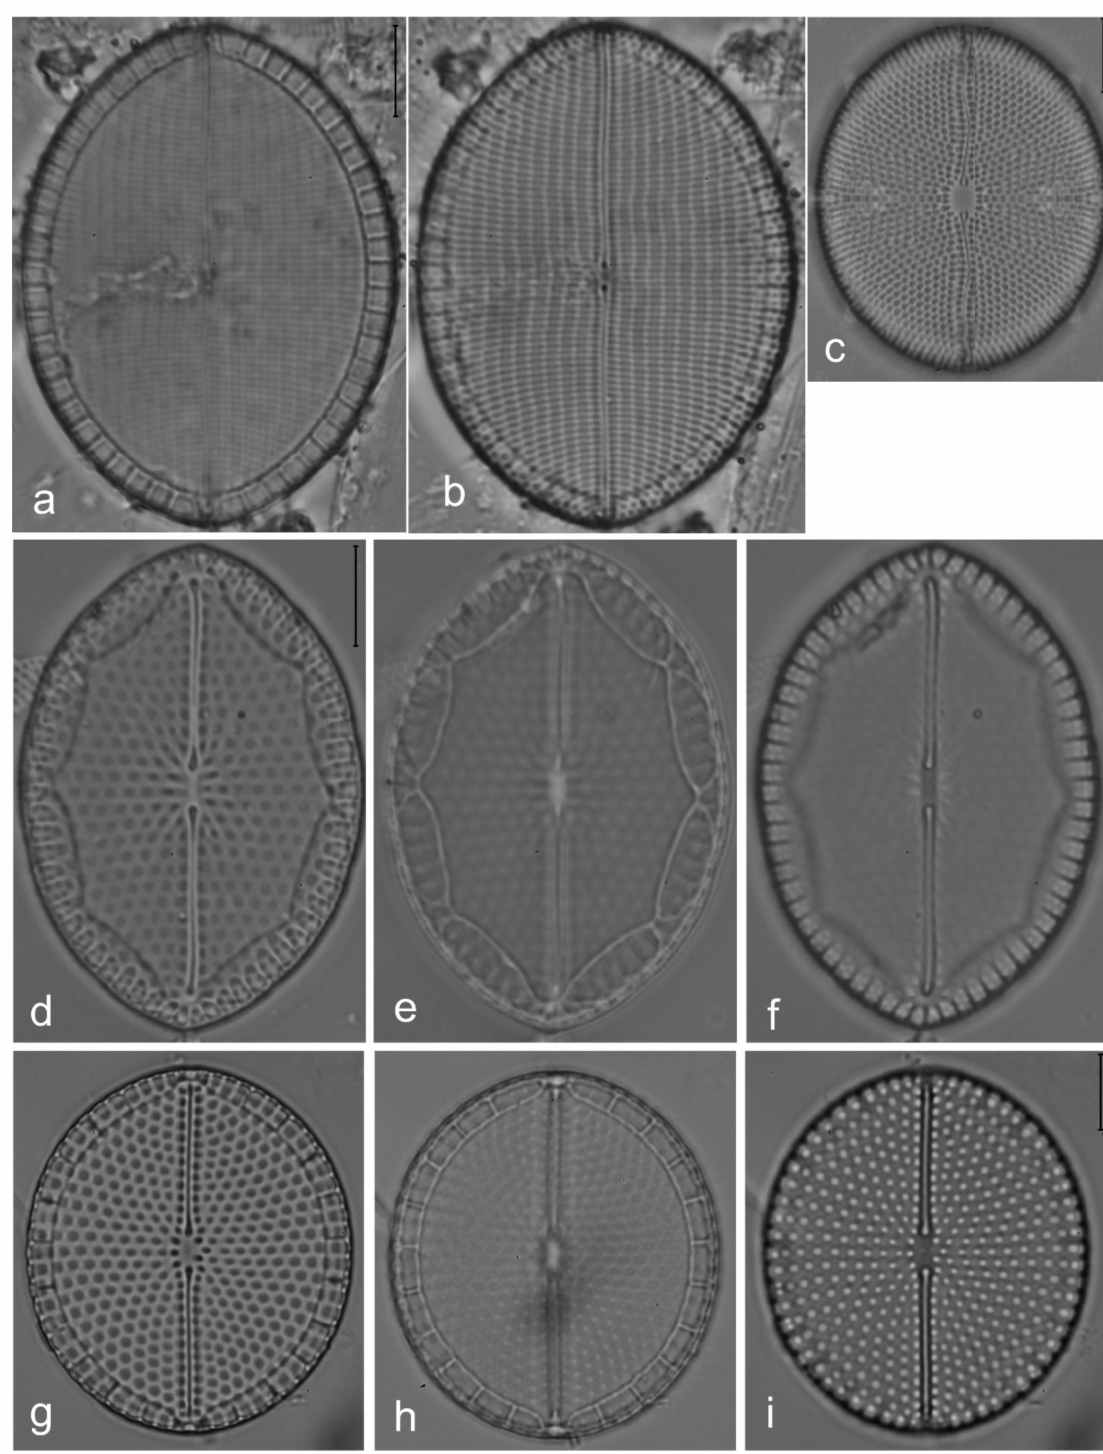
Figure 18. ( a , b ) Mastogloia ovata ; ( c ) M . cocconeiformis ; ( d – f ) M . fimbriata in different focal planes; ( g – i ) M . cribrosa valve in different focal planes. Scale bar = 10 µ